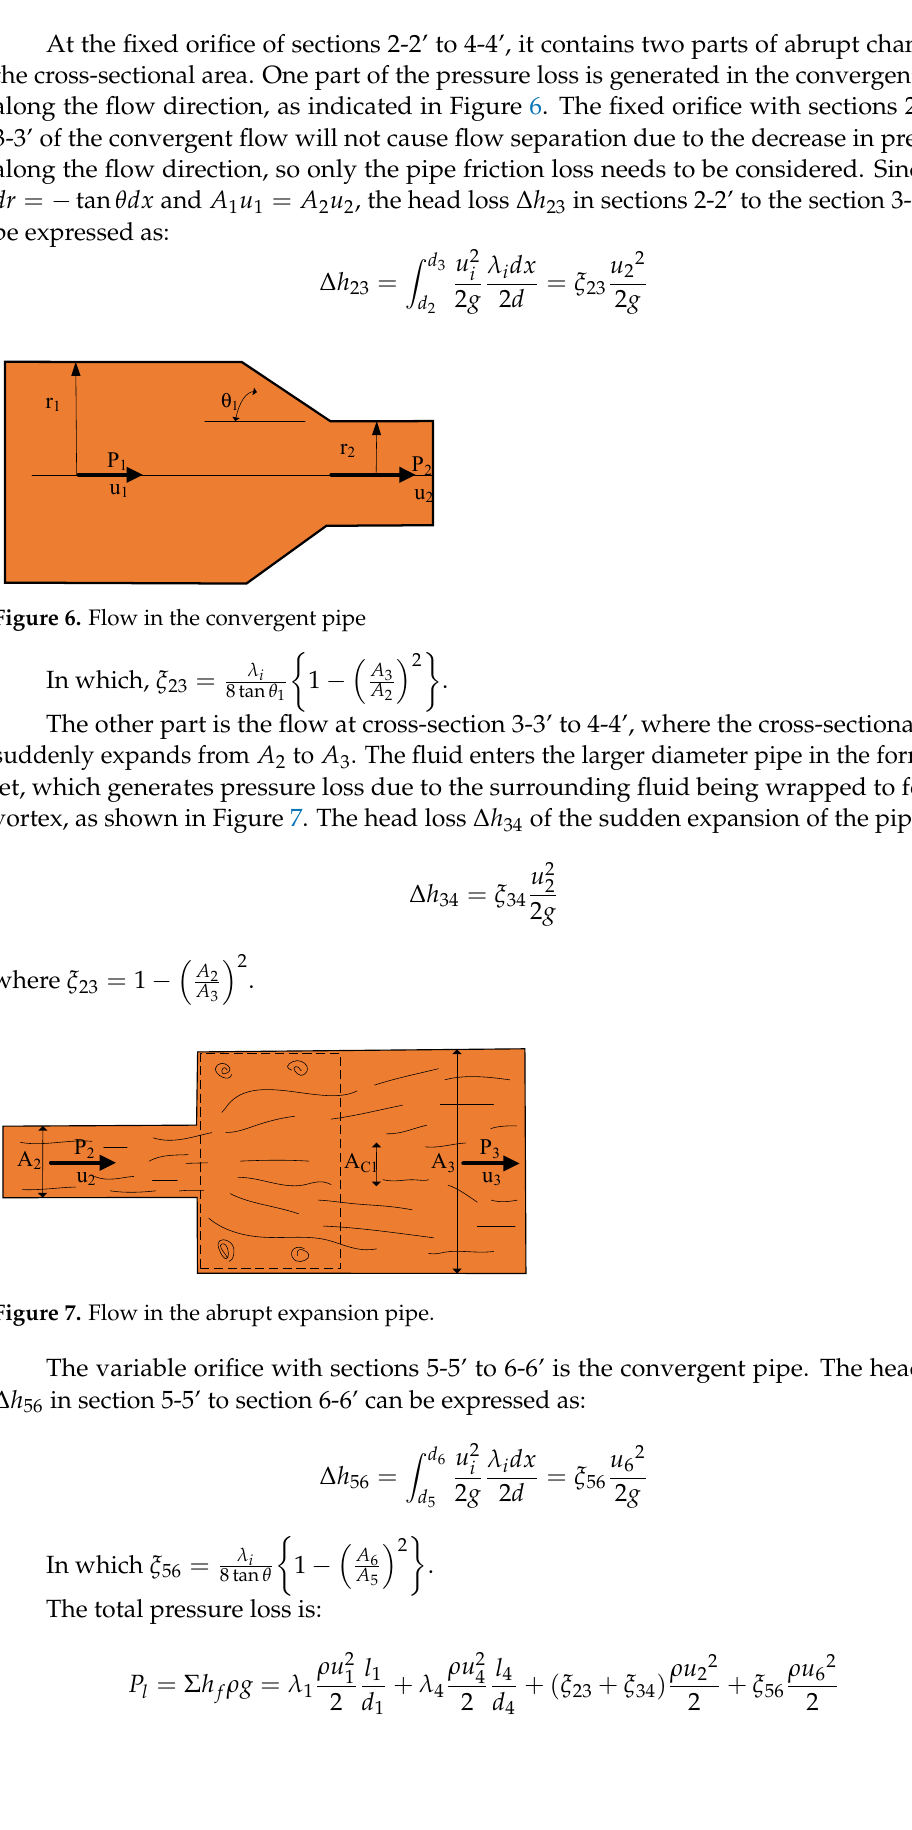
Figure 5. The simplify the flow pipe of the nozzle.